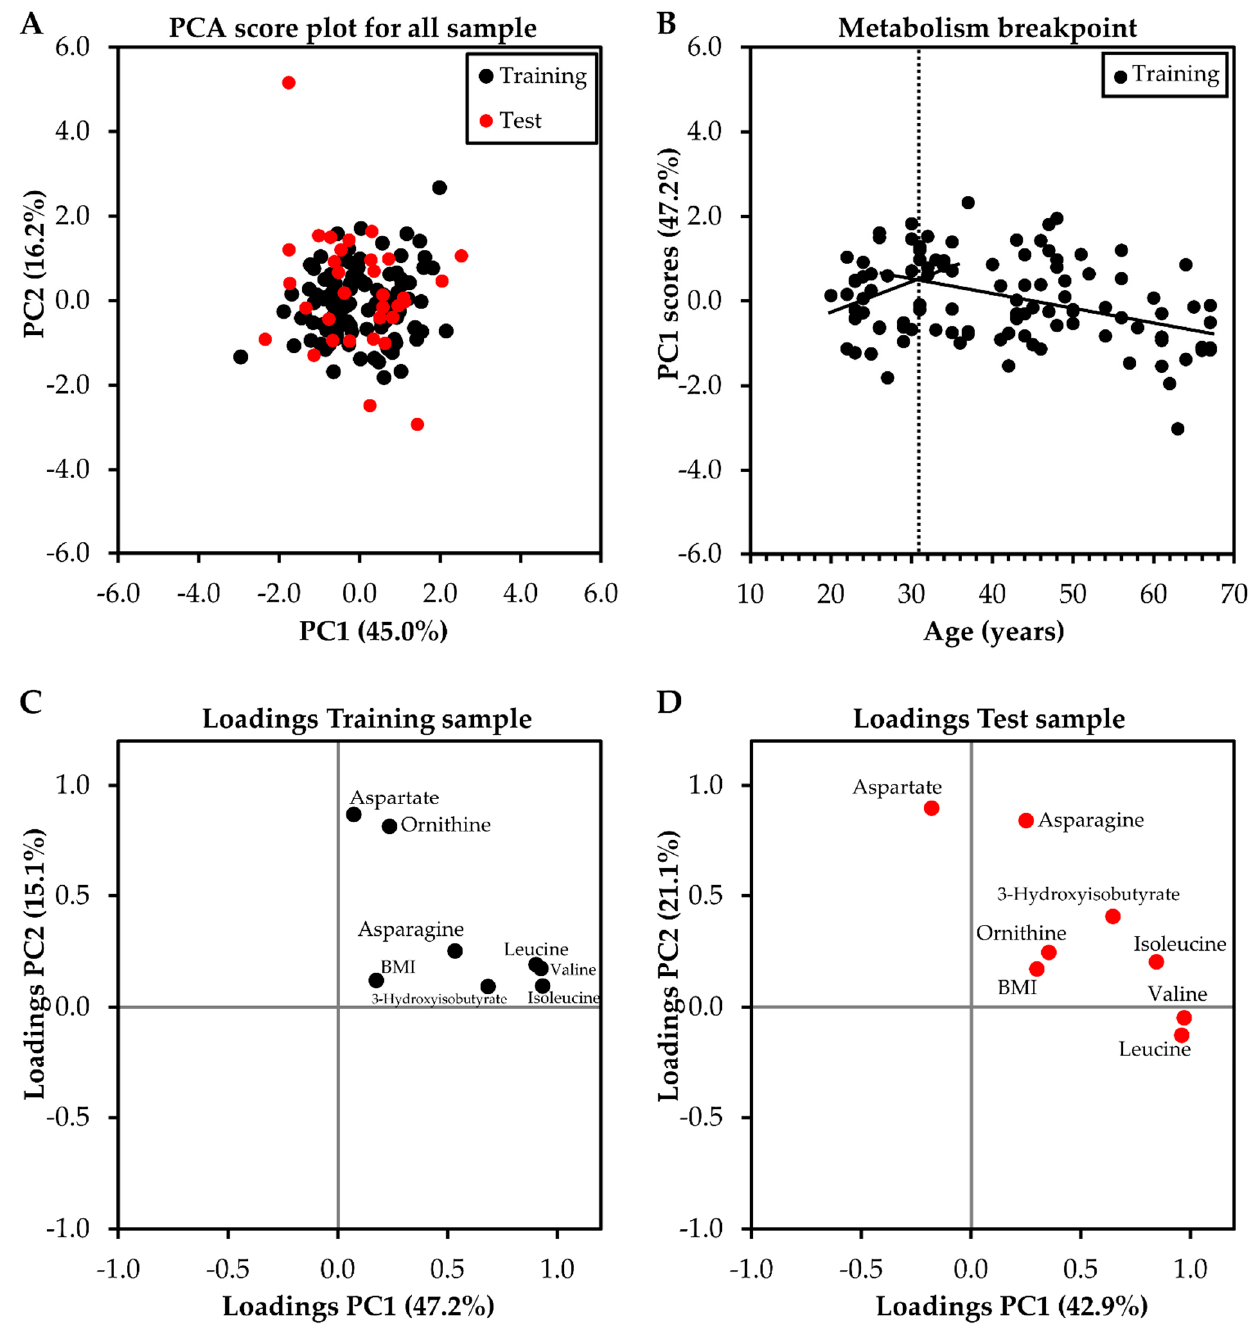
Figure 3. Score ( A ) and loading ( C , D ) plots of Principal Component Analysis (PCA) of main serum metabolites related to aging. Illustration of the metabolism breakpoint ( B ) from the intersection (dashed line) between the two straight lines (age vs. PC1 scores). Black and red circles represent Training and Test samples, respectively.